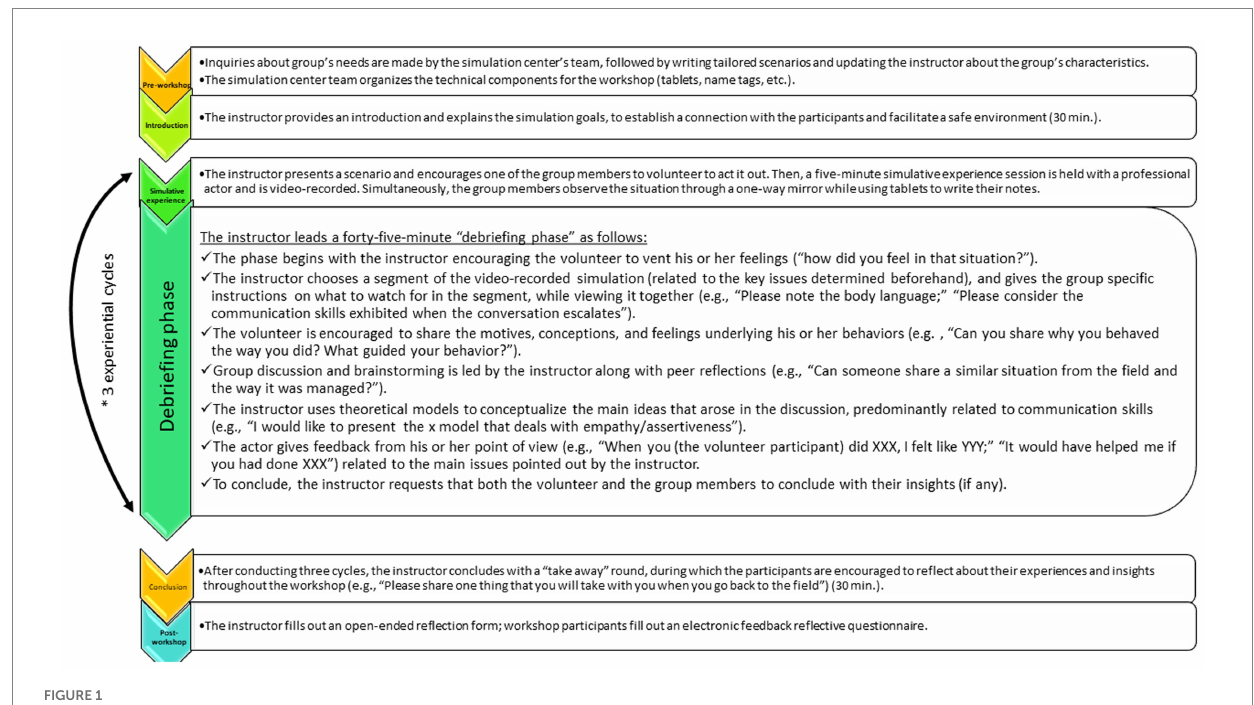
FIGURE 1 Instructor’s role throughout the SBL workshop. A step-by-step description of the simulation workshop process, emphasizing the role of the instructor throughout the process. [Note that although all workshops have the same structure, they differ in terms of their contents (different